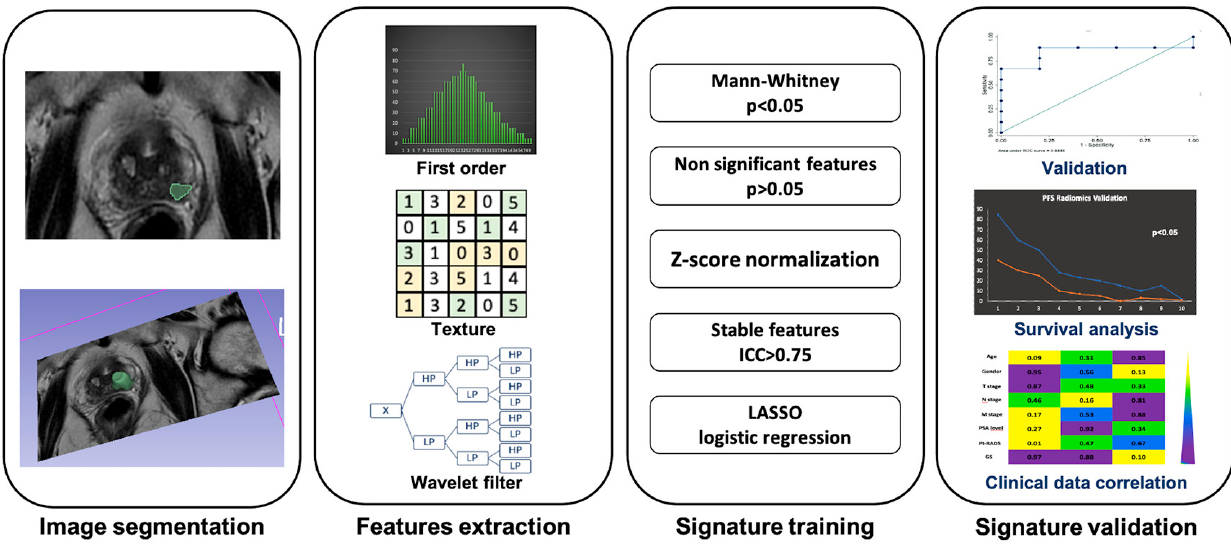
Figure 2. Radiomic analysis of prostate cancer. Image segmentation: prostate cancer segmented in a semi-automatic manner on axial T2, feature extraction: first order statistical features, texture features and wavelet filter, signature training: statistical analysis performed on mineable data extracted, signature validation: radiomic prognostic model validated on external